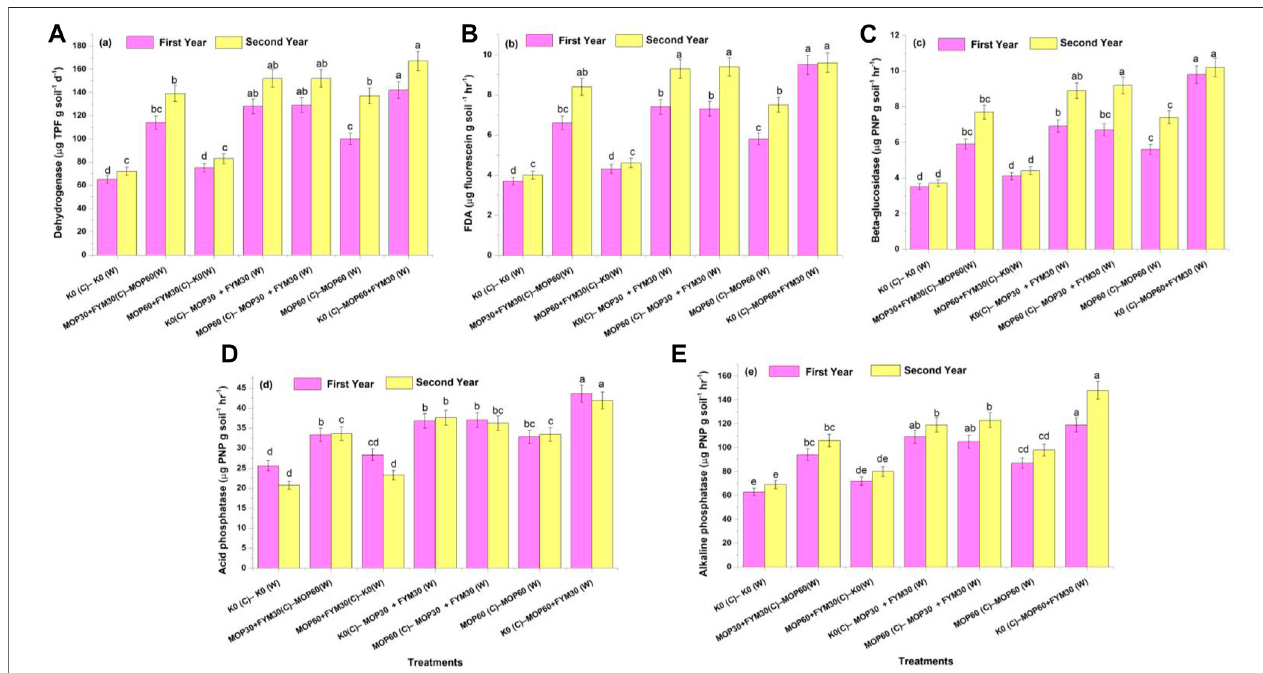
FIGURE 2 | Effect of integrated K application on soil enzymatic activities among treatments: dehydrogenase activity (A) ; FDA activity (B) ; beta-glucosidase activity (C) ; acid phosphatase activity (E) ; and alkaline phosphatase activity (E) .